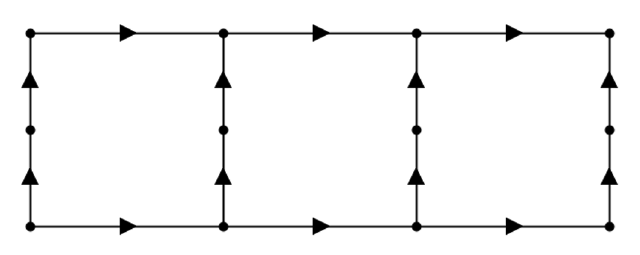
Figure 6 . The poset denoted by G ([1 , 1 , 1 , 1] , [0 , 0 , 0] , [0 , 0 , 0])